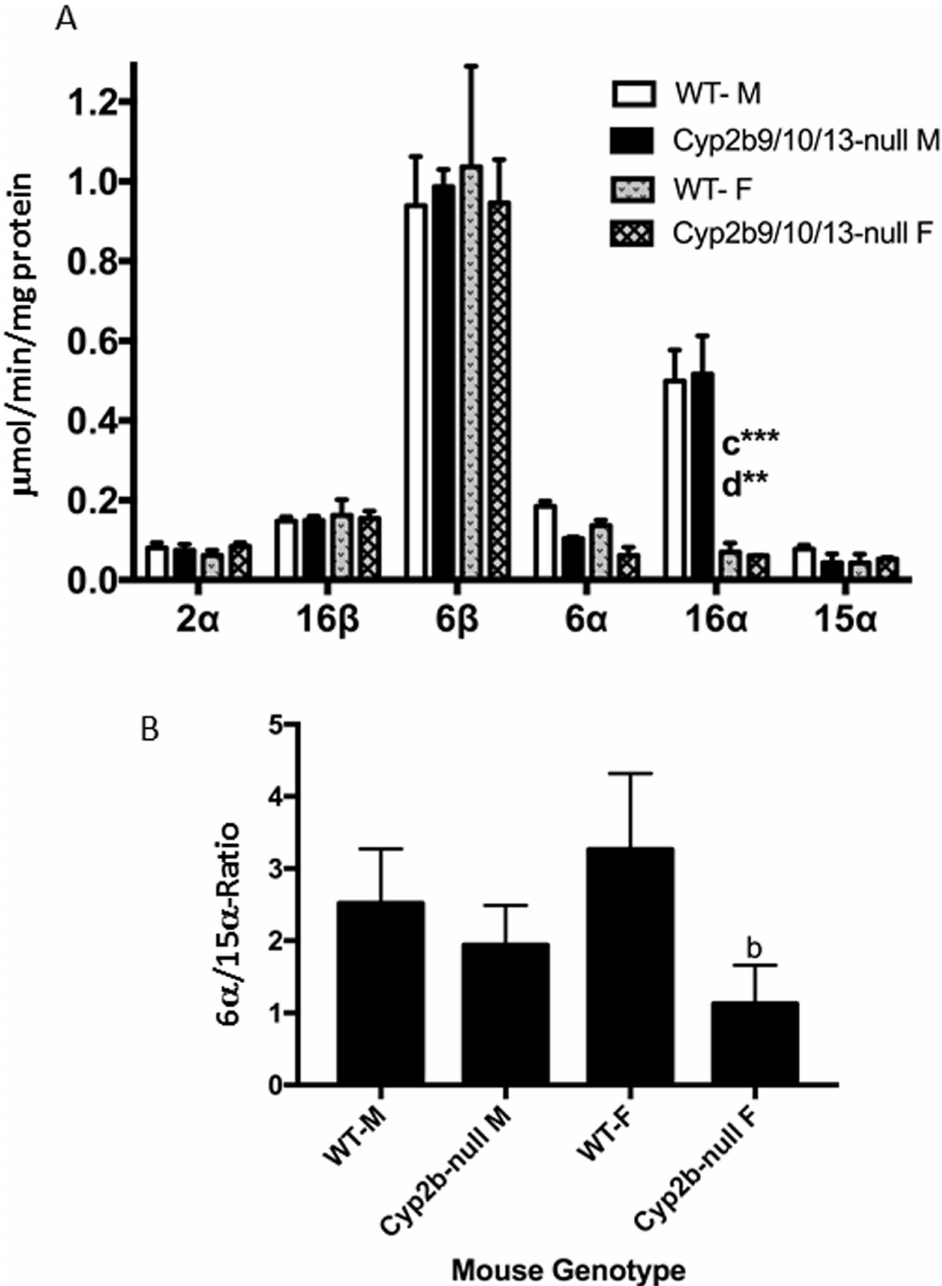
Fig 7. Testosterone hydroxylation determined in WT and Cyp2b9/10/13-null mice. (A) Testosterone hydroxylation was determined in male and female WT and Cyp2b9/10/13-null mice as describedin the Materials and Methods. Data are presented as mean specific activity ( μ mol/min/mg protein) ± SEM (n = 4). (B) Ratio of 6 α /15 α -hydroxytestosterone as a biomarker of CYP sexual dimorphism in the liver. An a indicates a significantdifference betweenWT male and Cyp2b9/10/13-null male mice, b indicatesa significant difference betweenWT female and Cyp2b9/10/13-null female mice, c indicatesa significantdifference betweenmale and female WT mice and d indicatesa significantdifference betweenthe male and female Cyp2b9/10/13-nullmice. Statistical differences were determined by two-way ANOVA followedby Fisher’s LSD as the post-hoc test in (A) and one-wayANOVA followedby Fisher’s LSD in (B). A letter without an asterisk indicatesa significanceof p < 0.05, asterisk indicate significanceof * p < 0.01, ** p < 0.001,and *** p <